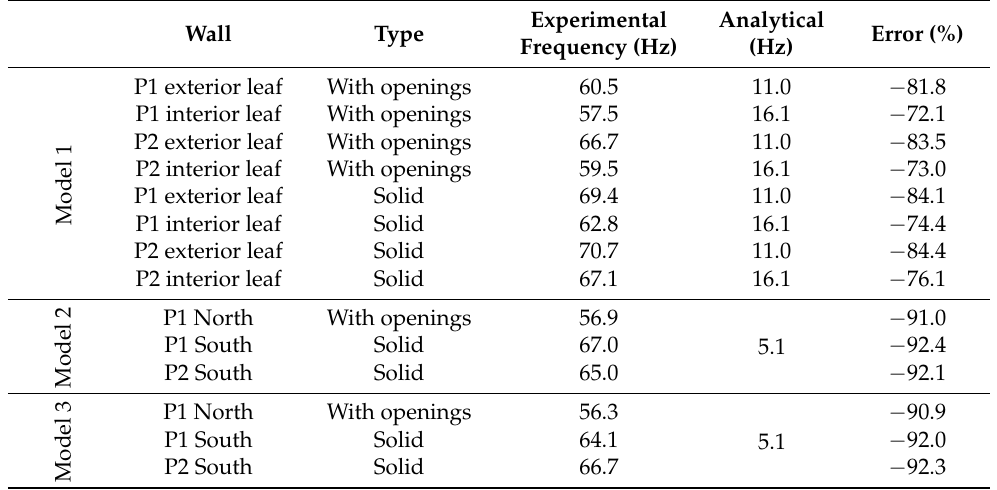
Table 7. Comparison between experimental frequencies and analytical proposal from [14].